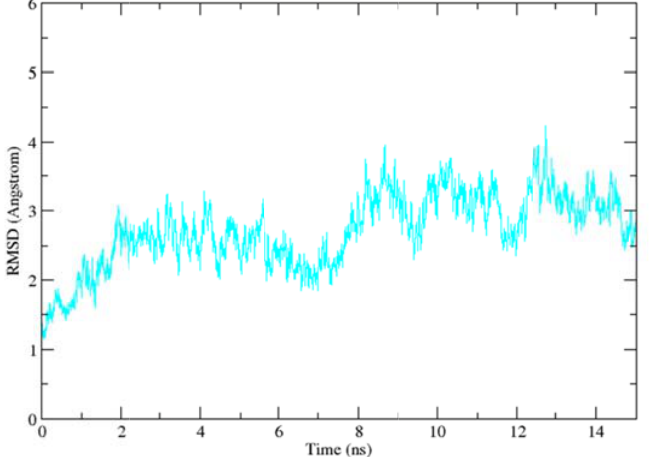
ction of veratrol wit